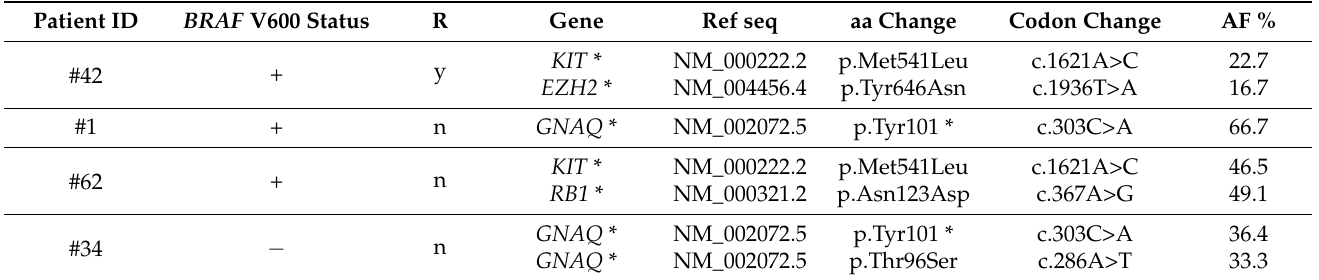
Table 2. Melanoma driver gene pathogenic mutations detected by Whole-Exome Sequencing (WES) acquired in the post-therapy melanoma